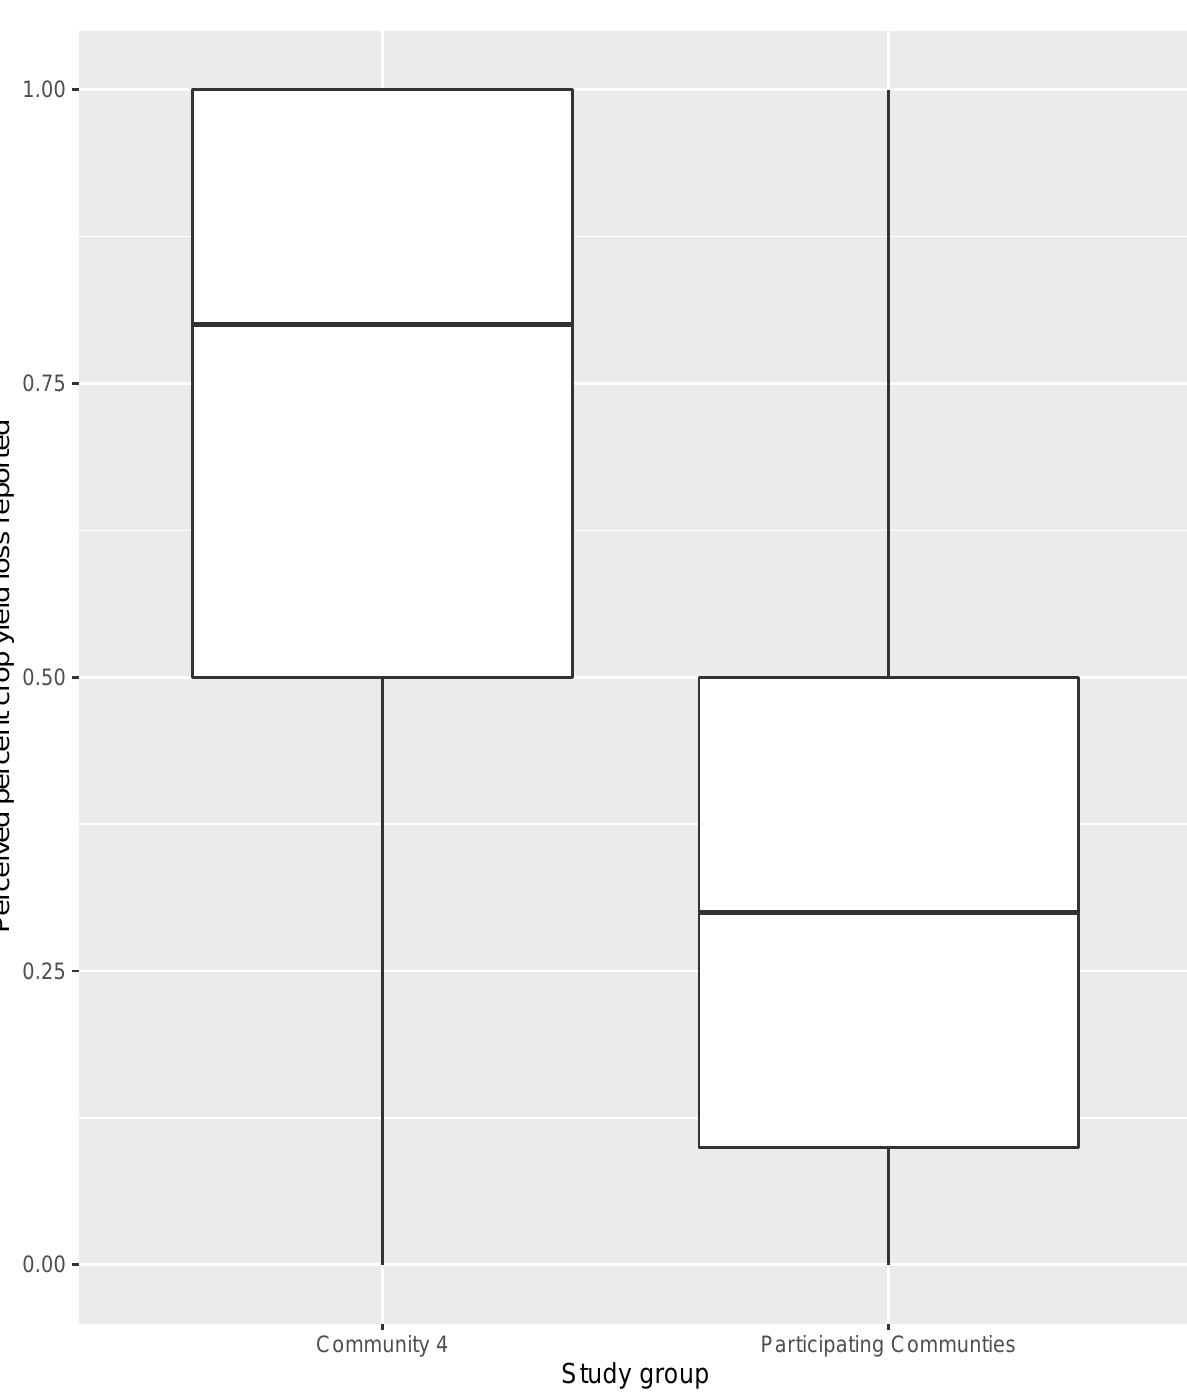
Figure 3. Reported perceived percent of crop yield loss in the past harvest season due to crop raiding in Community 4 ( n = 41 respondents) vs. the participating communities ( n = 93